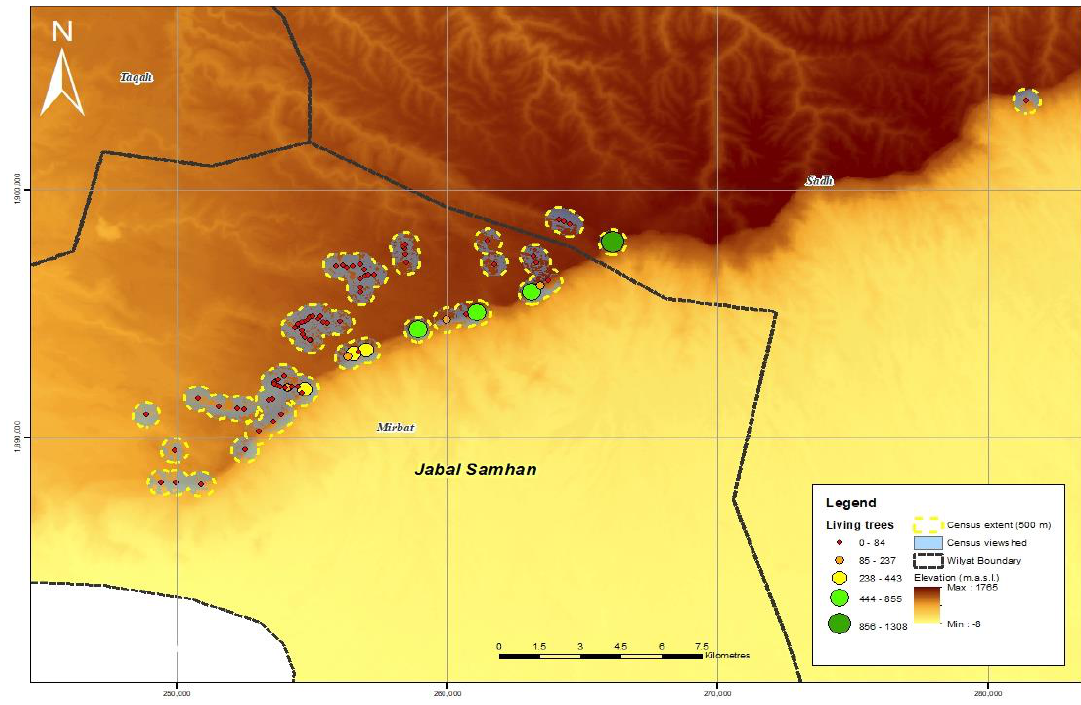
Figure 5. Distribution of census survey points, viewshed areas (depicted in blue within the dashed